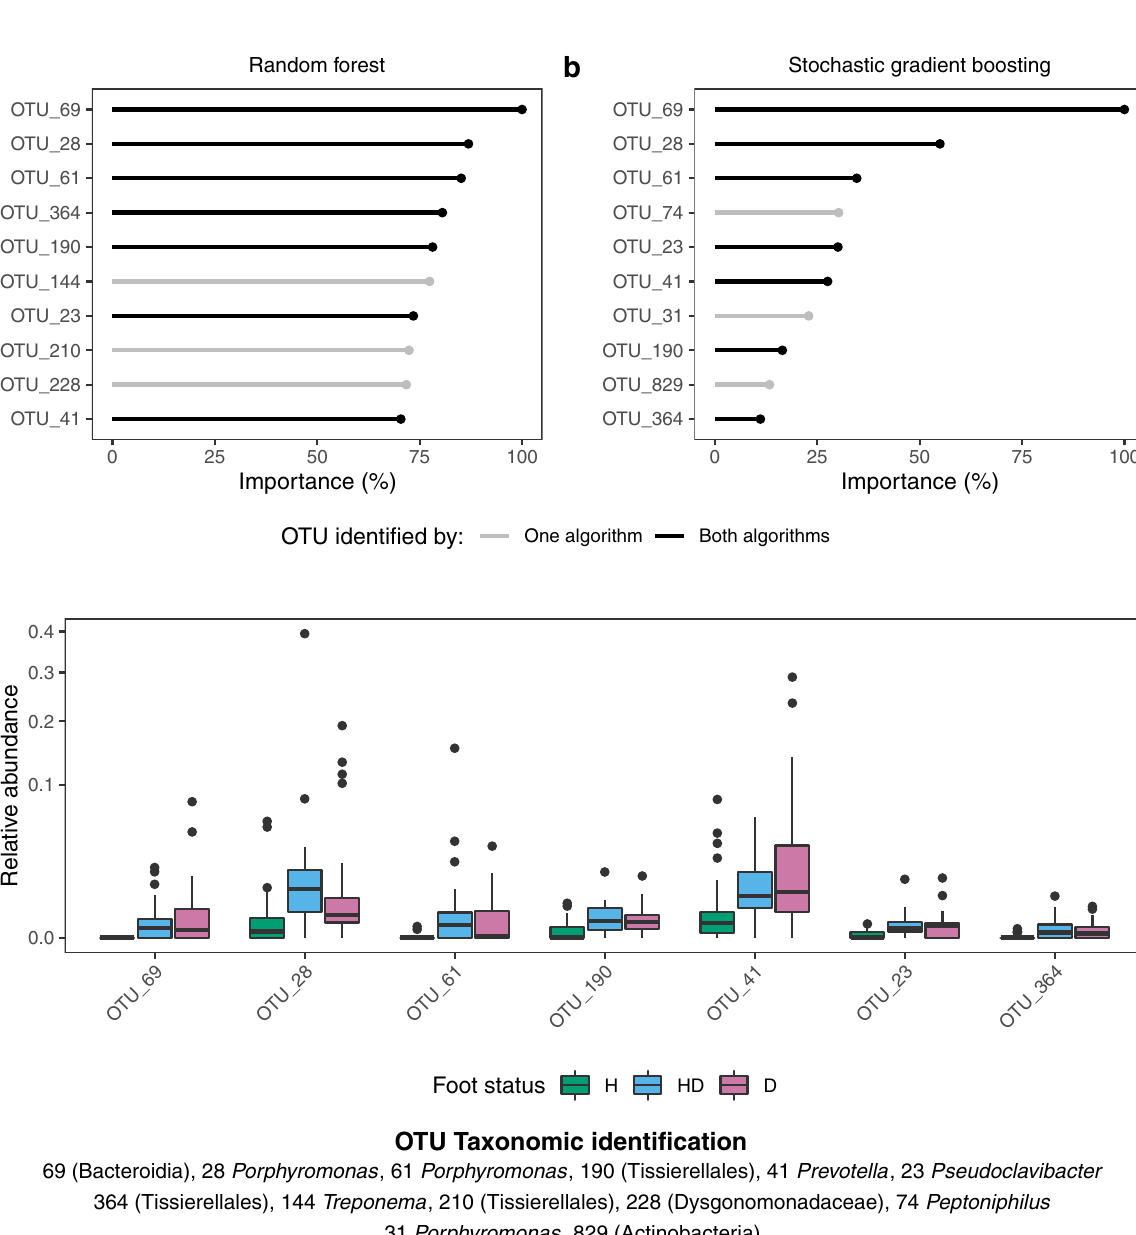
Figure 3. Composition of the IDS microbiota is predictive of footrot status of sheep. Importance of features retained in ( a ) random forest and ( b ) stochastic gradient boosting model for predicting disease status. Importance is scaled as a percentage relative to the importance of the most important feature. ( c ) Boxplots of relative abundance by foot status for operational taxonomic units (OTUs) identified by both random forest and stochastic gradient boosting model. H = healthy foot of healthy sheep; HD = healthy foot of diseased sheep; D = diseased foot. Number of samples (n) =